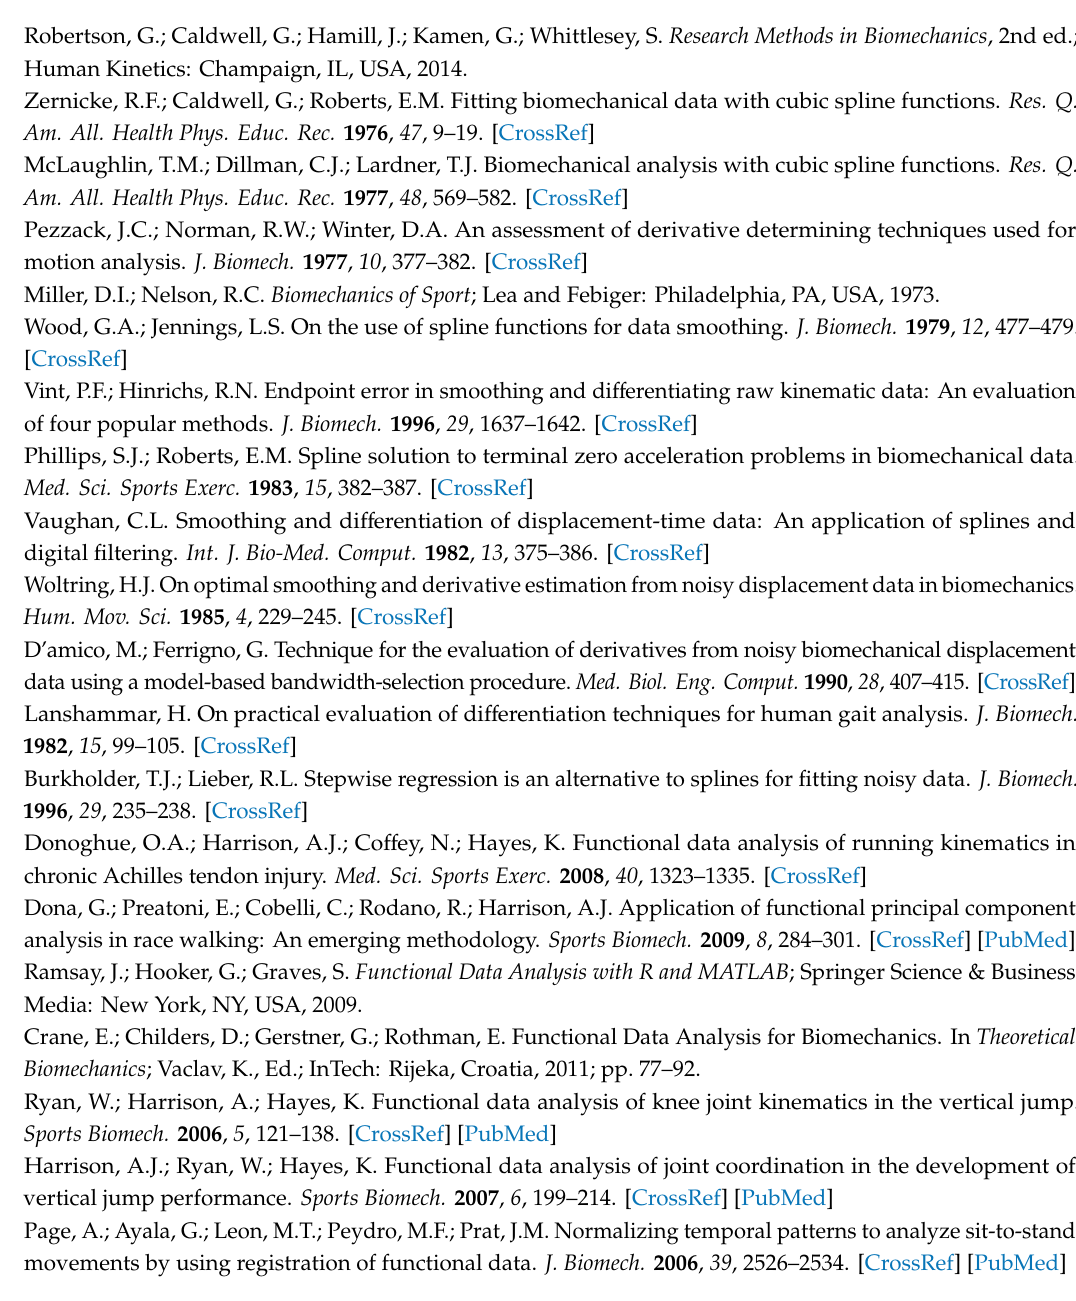
Figure A5. Smoothing using quintic spline basis, λ = 1 × 10 − 12 and penalized second-order derivative.